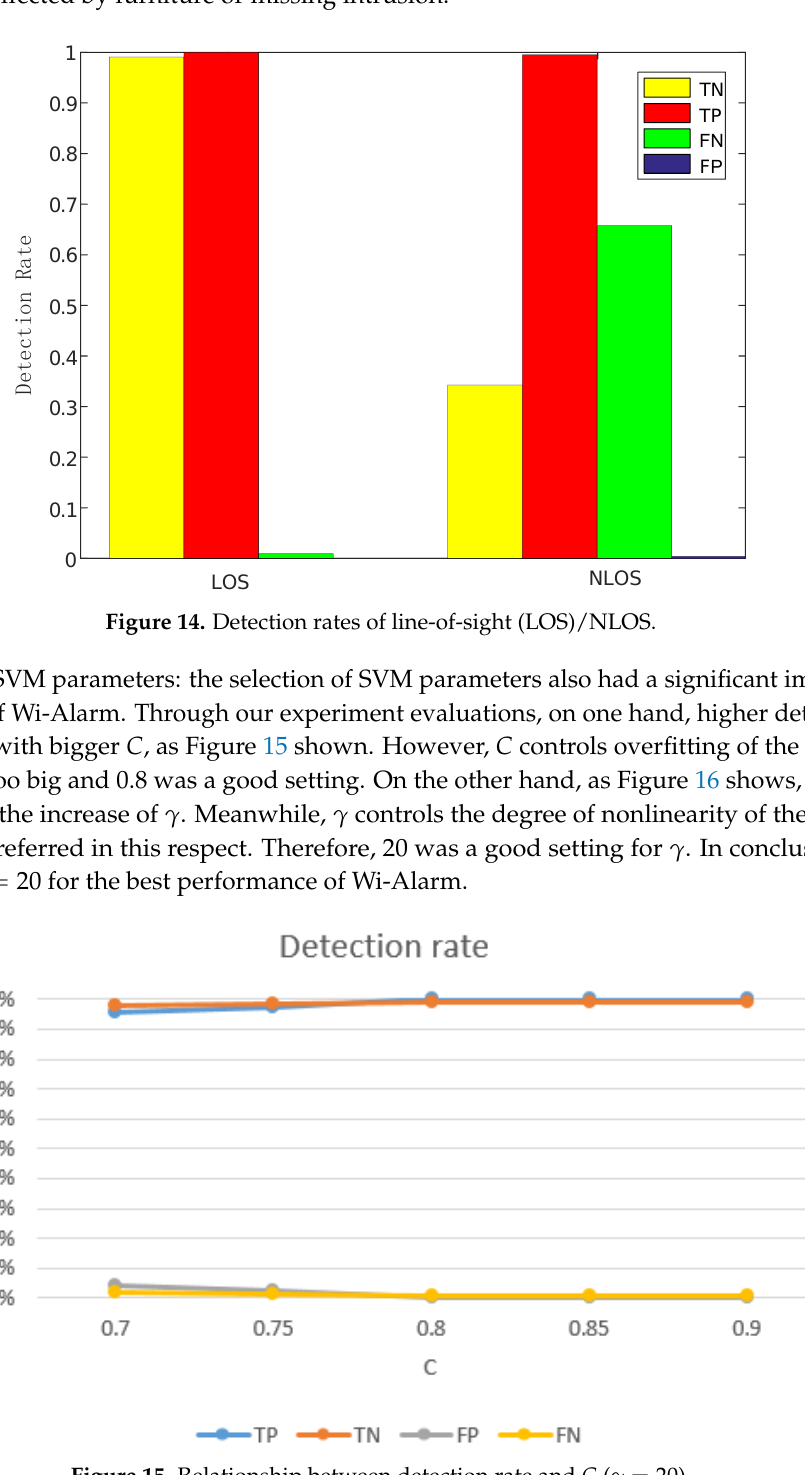
Figure 15. Relationship between detection rate and C ( γ =